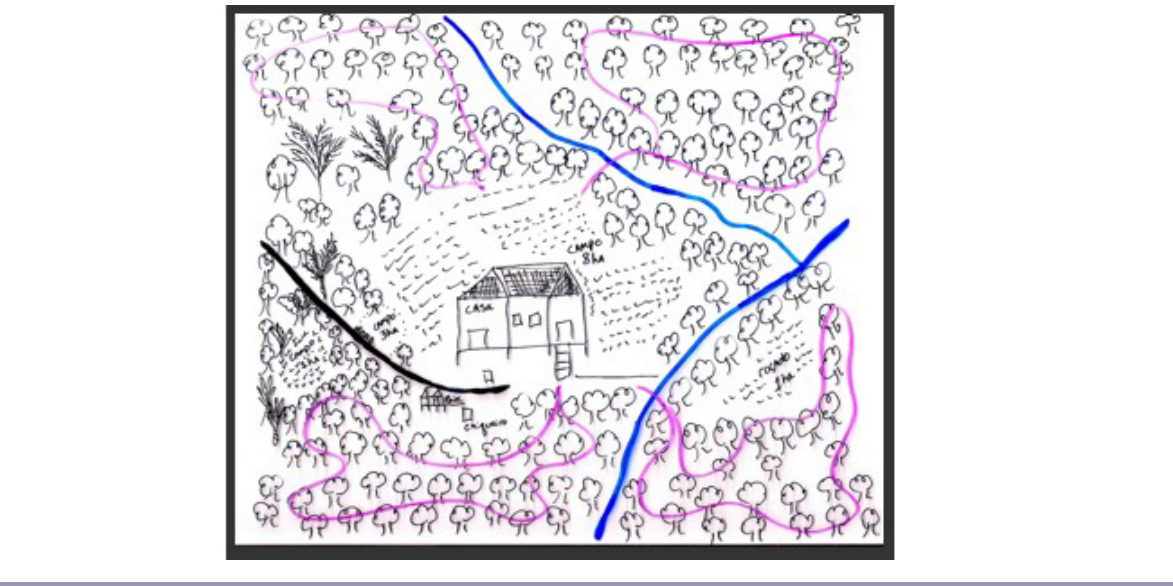
Fig. 1. Example of a colocação, or individual homestead. Black lines represent dirt roads connecting households; blue lines represent waterways; purple lines represent a household’s rubber trails. The entire forest on the reserves is divided into household forest properties. It is allocated based on the number of rubber trails per property. Each trail is cut to maximize encounters with rubber and Brazil-nut trees and requires on average 100–125 ha of forest to create one forest extractive trail; the rubber trail unit itself accounts for approximately 10% of the forest. In the extractive reserve forest landscape, all forest is under active management and use. The sketch map is not drawn to scale, but is representative of a typical household’s